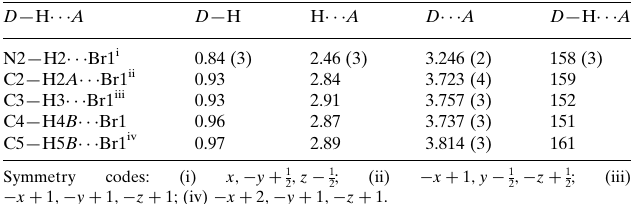
Hydrogen-bond geometry (A˚ , (cid:4)